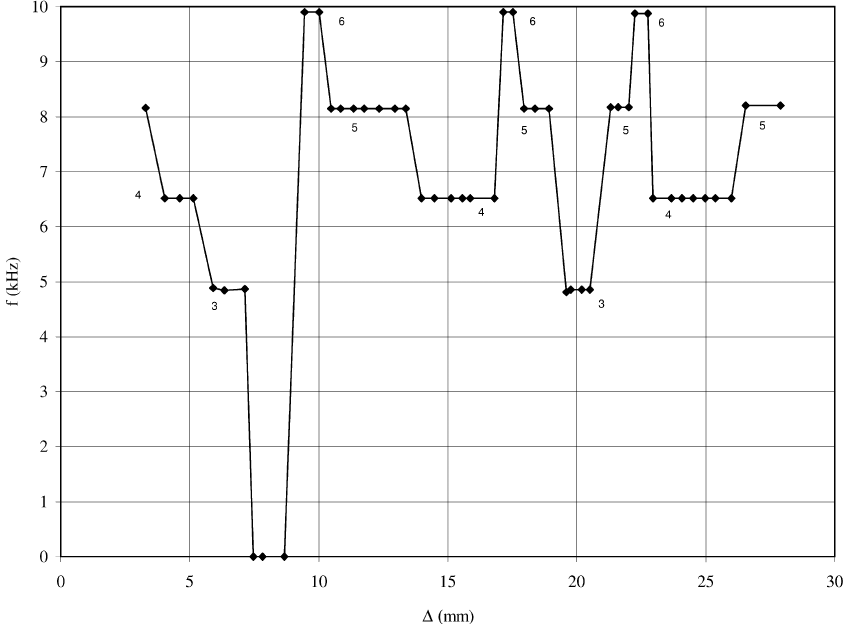
FIG. 8. Higher harmonics generation depending on magnet shift D from the upper end of the wire. The value D (cid:1) 20 mm corresponds to the wire